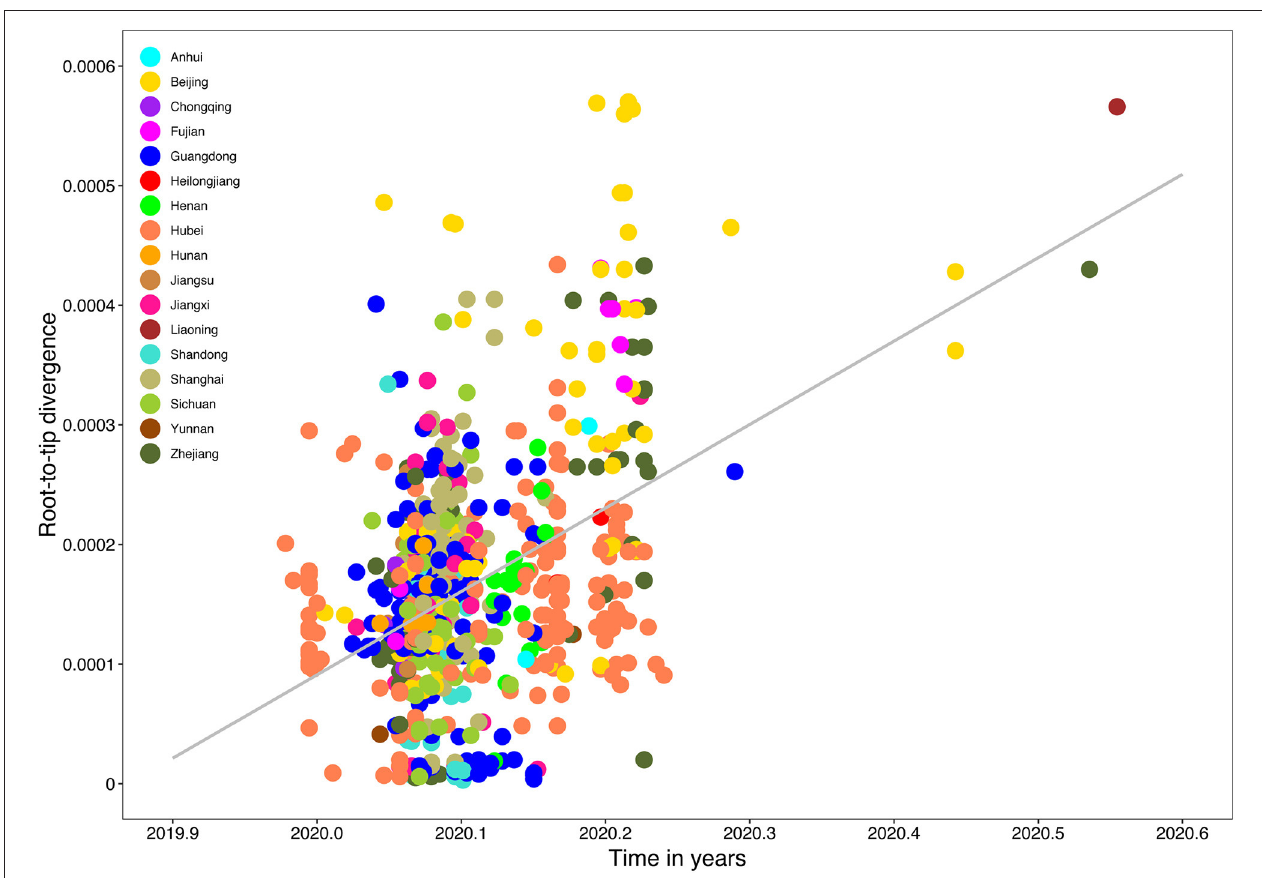
FIGURE 4 | Root-to-tip genetic divergence plot of SARS-CoV-2 from Mainland China. Root-to-tip genetic divergence for “dataset_729” from Mainland China in the Maximum likelihood tree (as shown in Figure 3 ) plotted against sampling date is shown. Colors indicate different sampling provinces from Mainland China. Gray color indicates linear regression